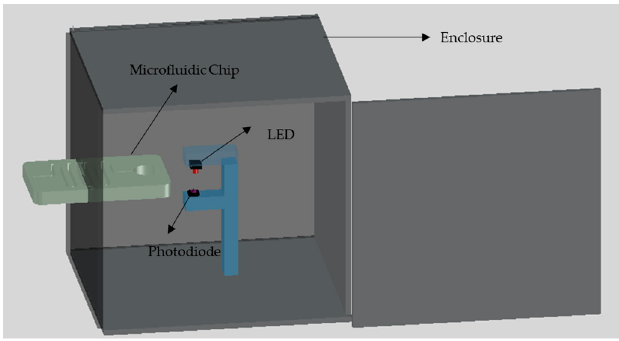
Figure 3 . The developed setup of the nitrite detection system. Figure 3. The developed setup of the nitrite detection